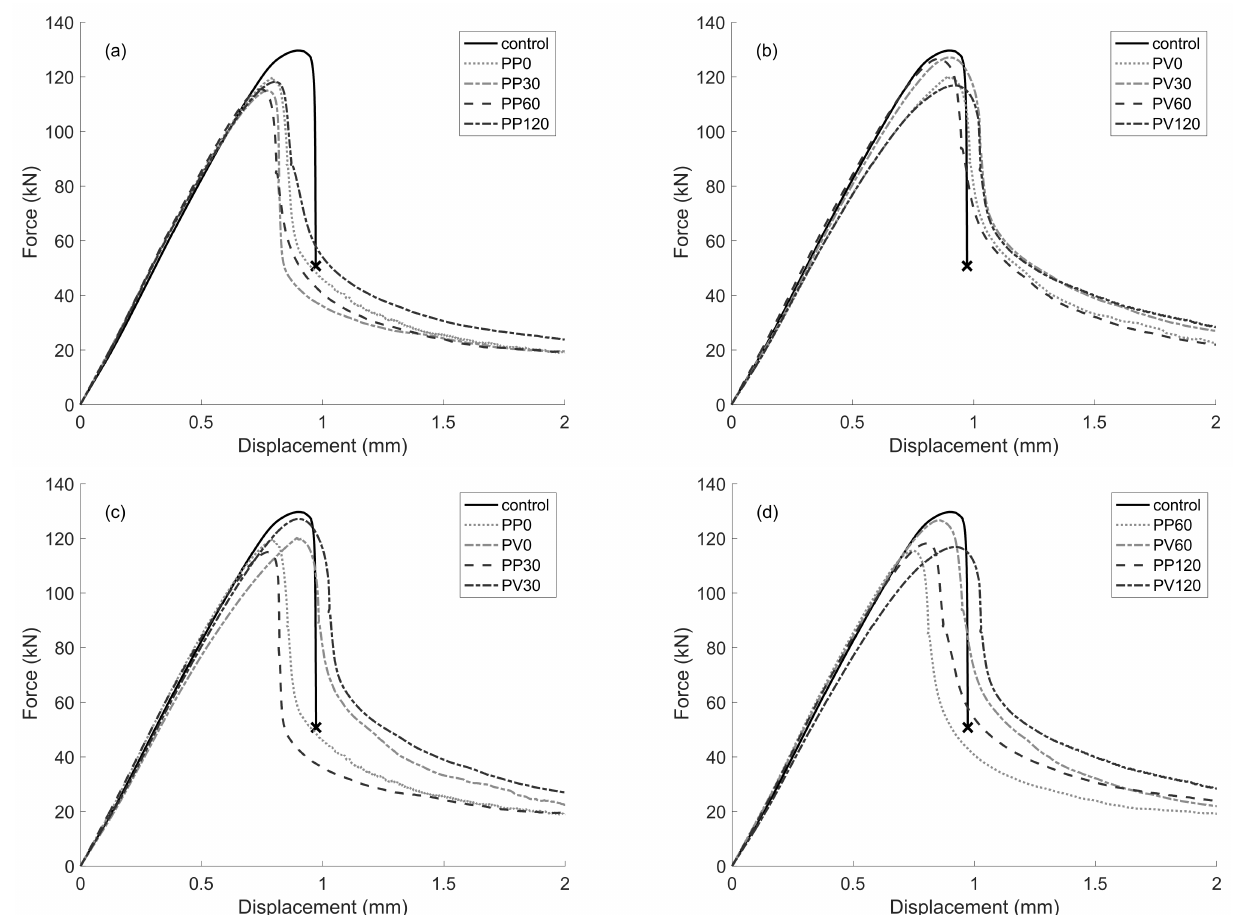
Figure 5. Force–displacement curves for PP and PV fiber specimens with different fiber treatment times tested in compression ( a , b ) and comparison between PP and PV s with different fiber treatment times tested in compression ( c , d